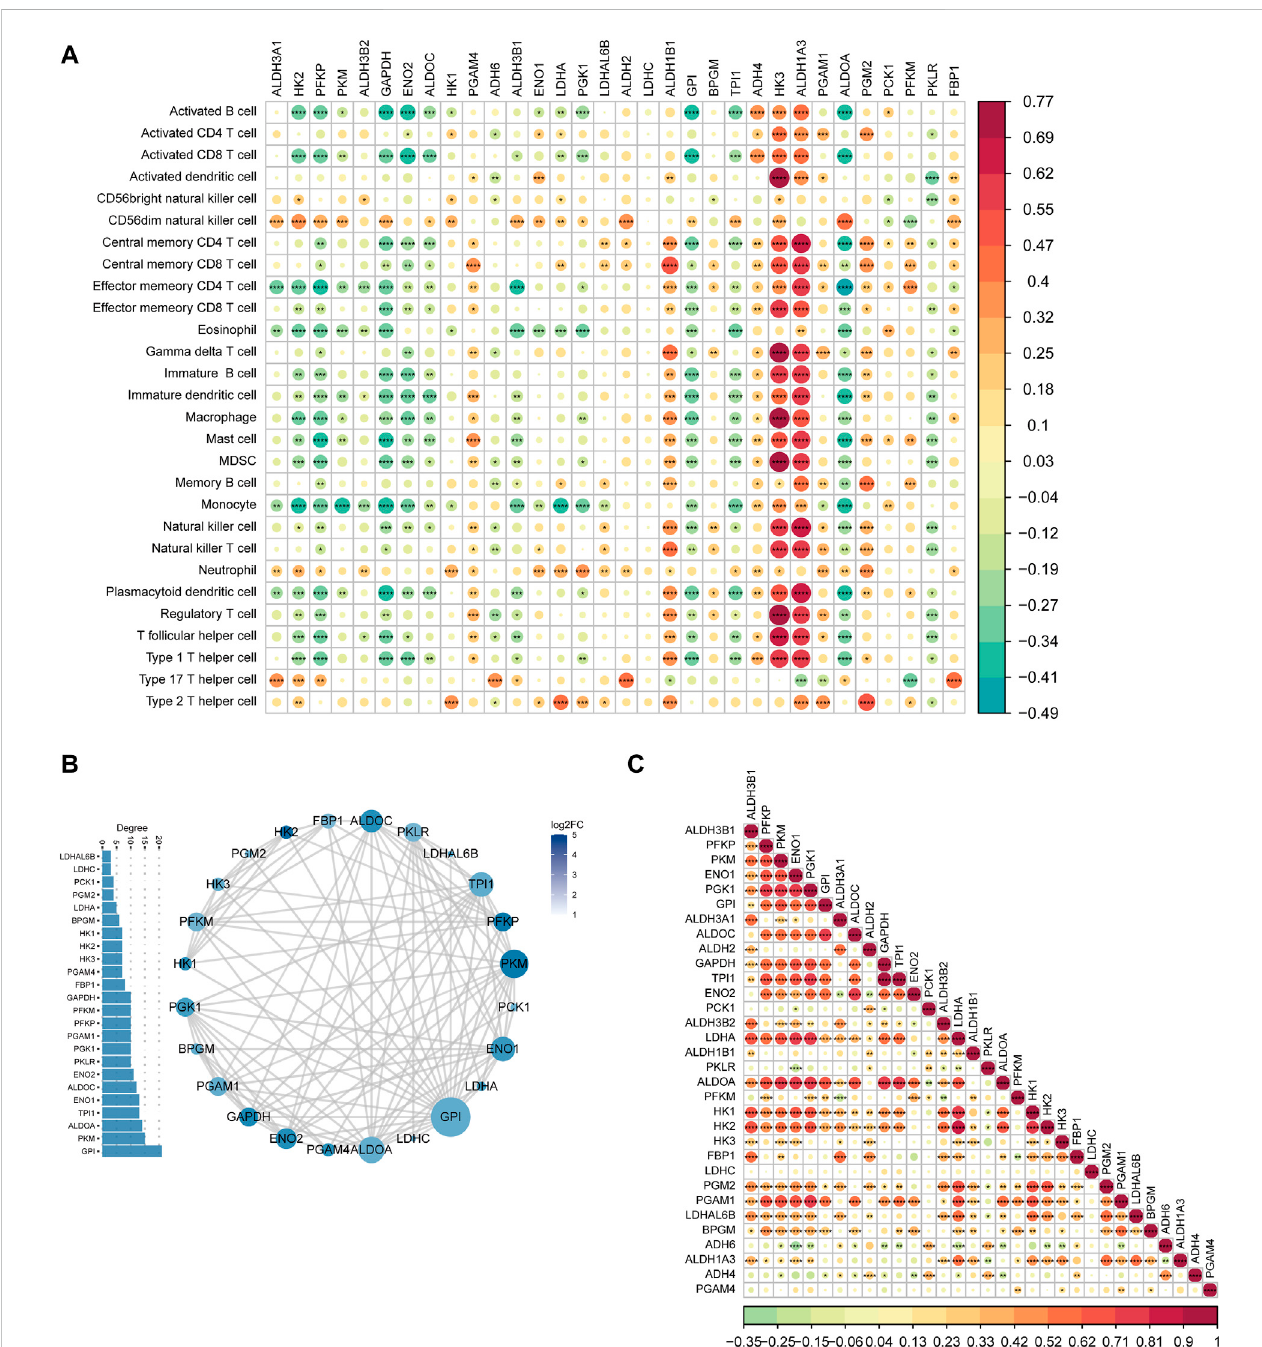
FIGURE 4 MMRG core gene immune microenvironment and protein-protein interaction (PPI) network. (A) The correlation between differential expression of MMRG and tumor immune cell in fi ltration (positive in red and negative in blue); (B) MMRG core gene protein-protein interaction (PPI) network. Color of the gene indicates the differential expression (log2FC) and the node size indicates the degree which also displayed by the barplot leftside; (C) Spearman correlation of MMRG core